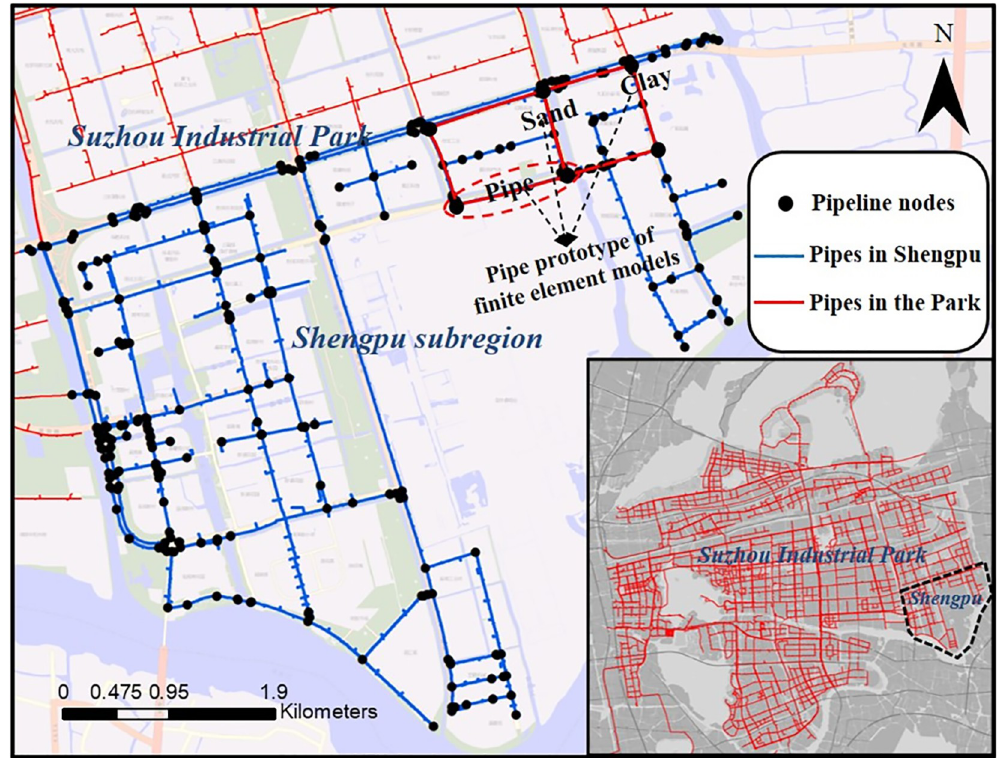
Fig 2. Prototype pipes from the Shengpu subregion of Suzhou Industrial Park. (Republished under a CC BY license, with permission from Suzhou Industrial Park Qingyuan Huayan Water Co. LTD, original copyright 2019).